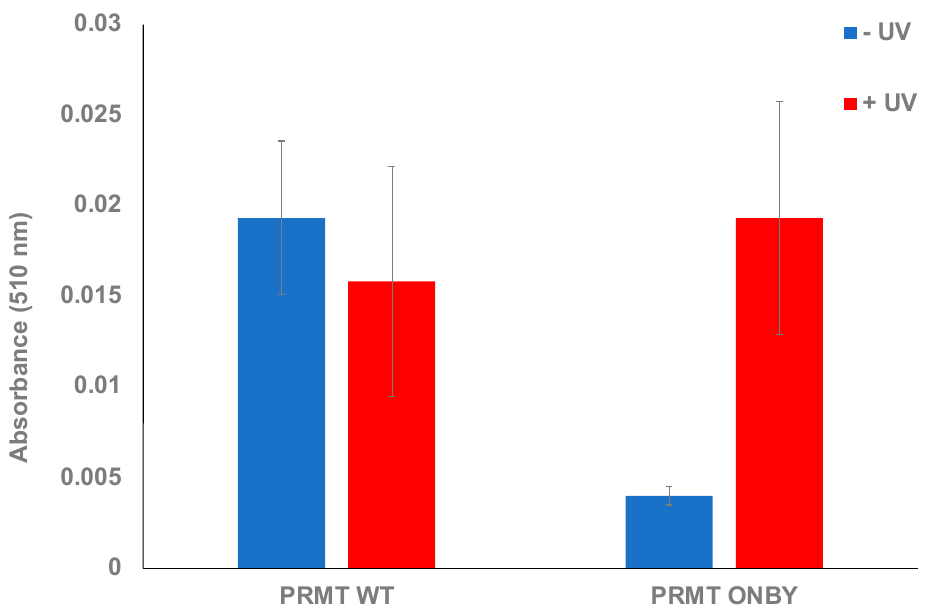
Figure 2. Endpoint assay of caged-PRMT1. Both wild-type protein and ONBY-PRMT1 were assayed in the presence and absence of UV irradiation (2 min at 365 nm). Within the degree of error, no significant effect was observed on the wild-type activity due to light irradiation. However, non-irradiated ONBY-PRMT1 did not possess significant methyltransferase activity unless briefly irradiated, which restored activity to wild-type levels.